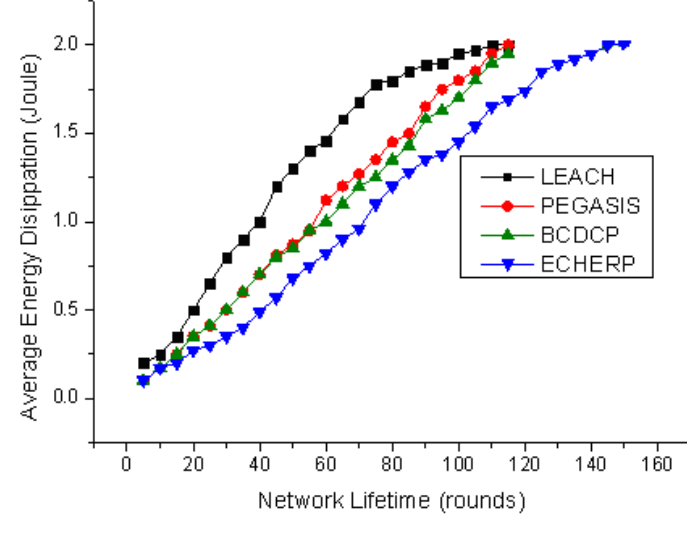
Figure 4. Average energy dissipation versus the network lifetime in rounds.